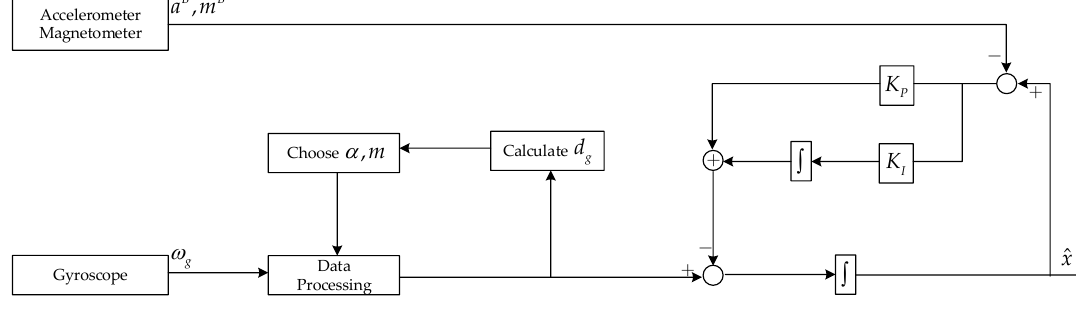
Figure 2. The structure of D-NCF algorithm.